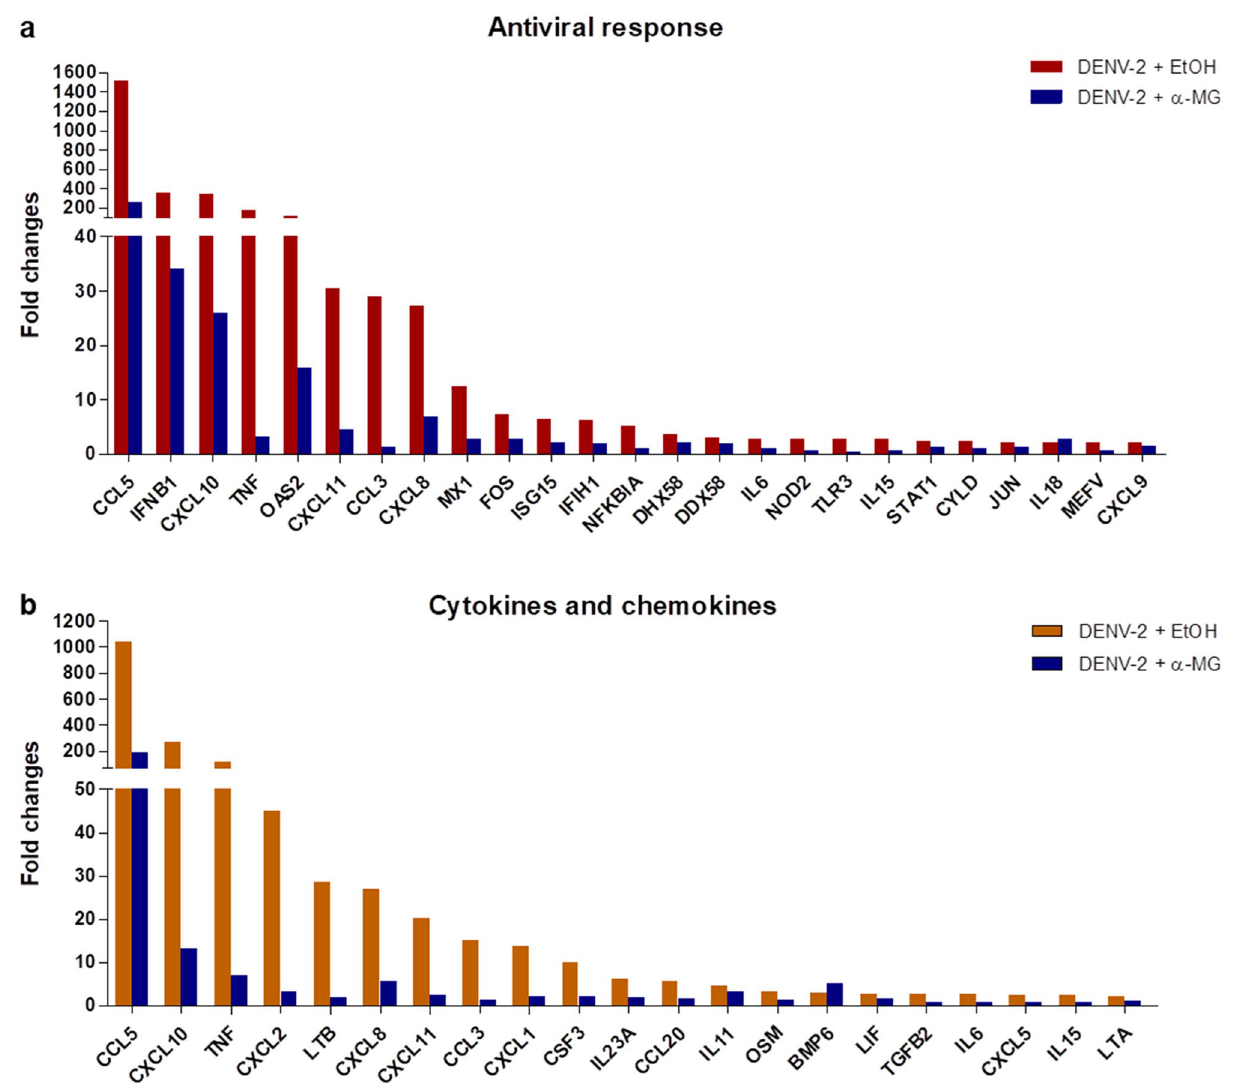
Figure 4. Real-time reverse transcription polymerase chain reaction (real-time RT-PCR) array profile of ( a ) antiviral genes, and ( b ) cytokine and chemokine genes in DENV-infected HepG2 cells in the presence or absence of 20 μM